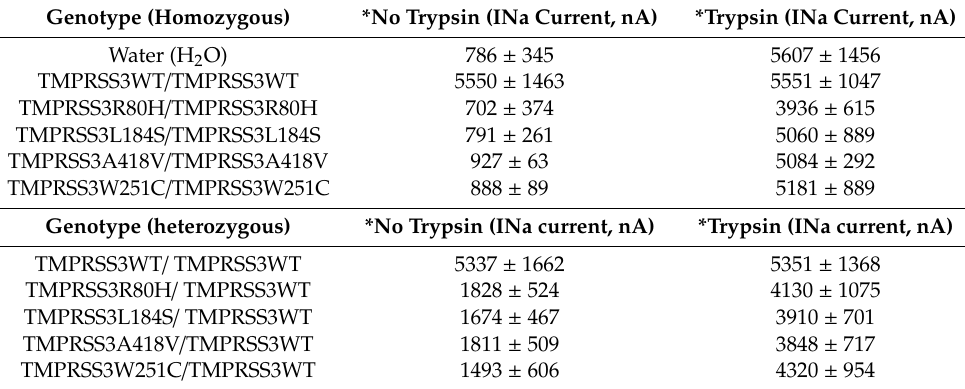
Figure 5. Functional expression of TMPRSS3 wild-type and mutant in Xenopus oocytes. Oocytes were injected with rat ENaC subunit in the presence of either ( A ) water (H 2 O), ( B ) TMPRSS3WT, and TMPRSS3 missense mutant, including ( C ) TMPRSS3R80H, ( D ) TMPRSS3L184S, ( E ) TMPRSS3A418V, and ( F ) TMPRSS3W251C. Water was used as a negative control. ( G ) All of the four missense mutant Na + currents were similar to water, wherein there was no evident Na + current and under 1000 nA in the quantitative analysis. In contrast, oocytes with the TMPRSS3WT emerging Na + current were 5550 ± 1463 nA. ( n ≥ 10). Table 3. Electrophysiological measurements in Xenopus